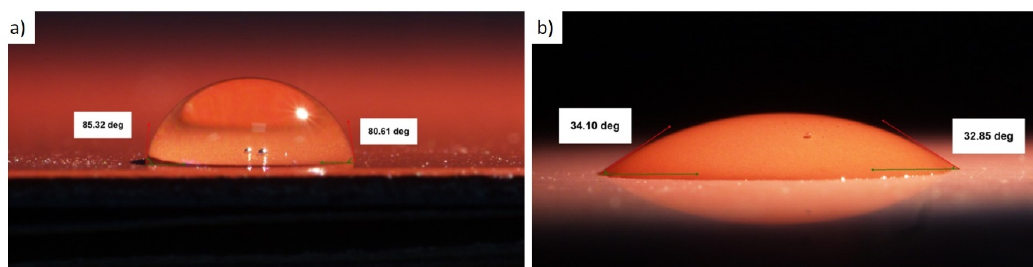
Figure 11. Contact angle measurements of sample Red-N ( a ) before and ( b ) after the degradation cyclic test.